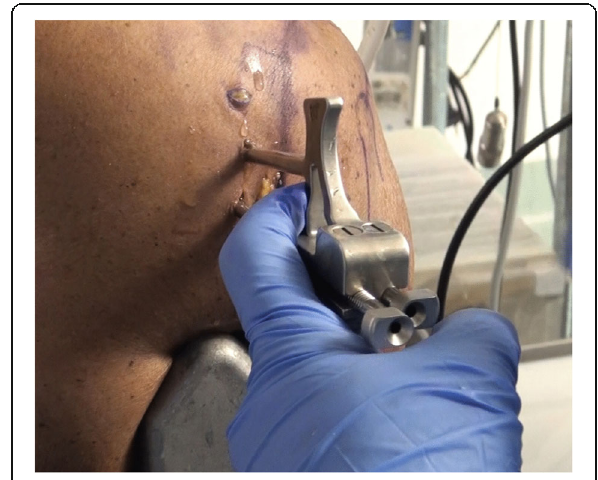
Fig. 2 Left shoulder. The guide is positioned posteriorly on the glenoid neck and two bullets are placed in the guide ’ s